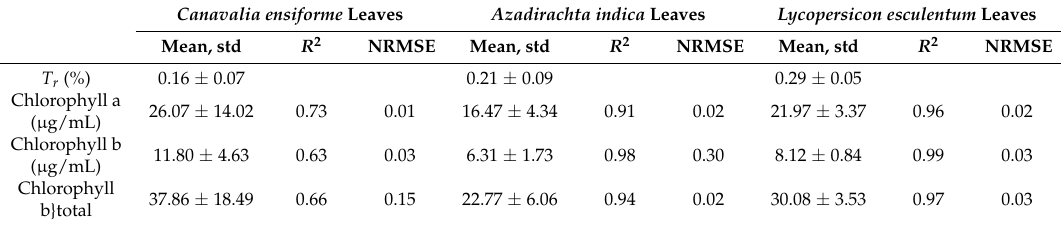
Table 3. Chlorophyll a, b and total content in Canavalia ensiforme , Azadirachta indica , and Lycopersicon esculentum leaves. Canavalia ensiforme Leaves Azadirachta indica Leaves Lycopersicon esculentum